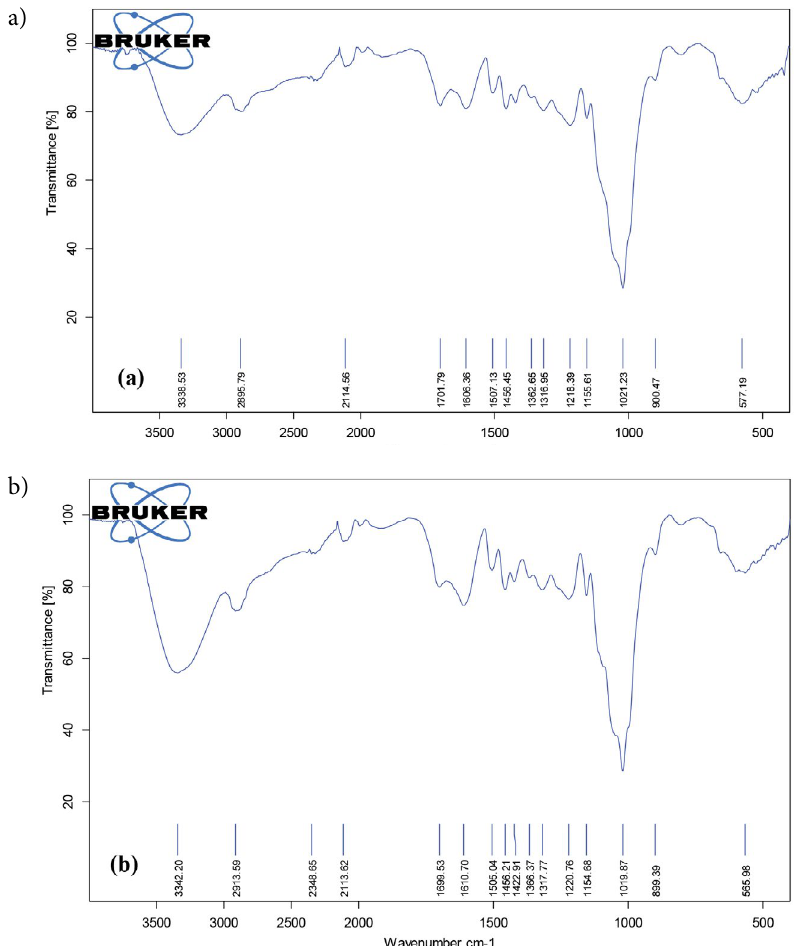
Fig. 2. FTIR spectra of (a) uncoated AAPS and (b) AV 17 coated